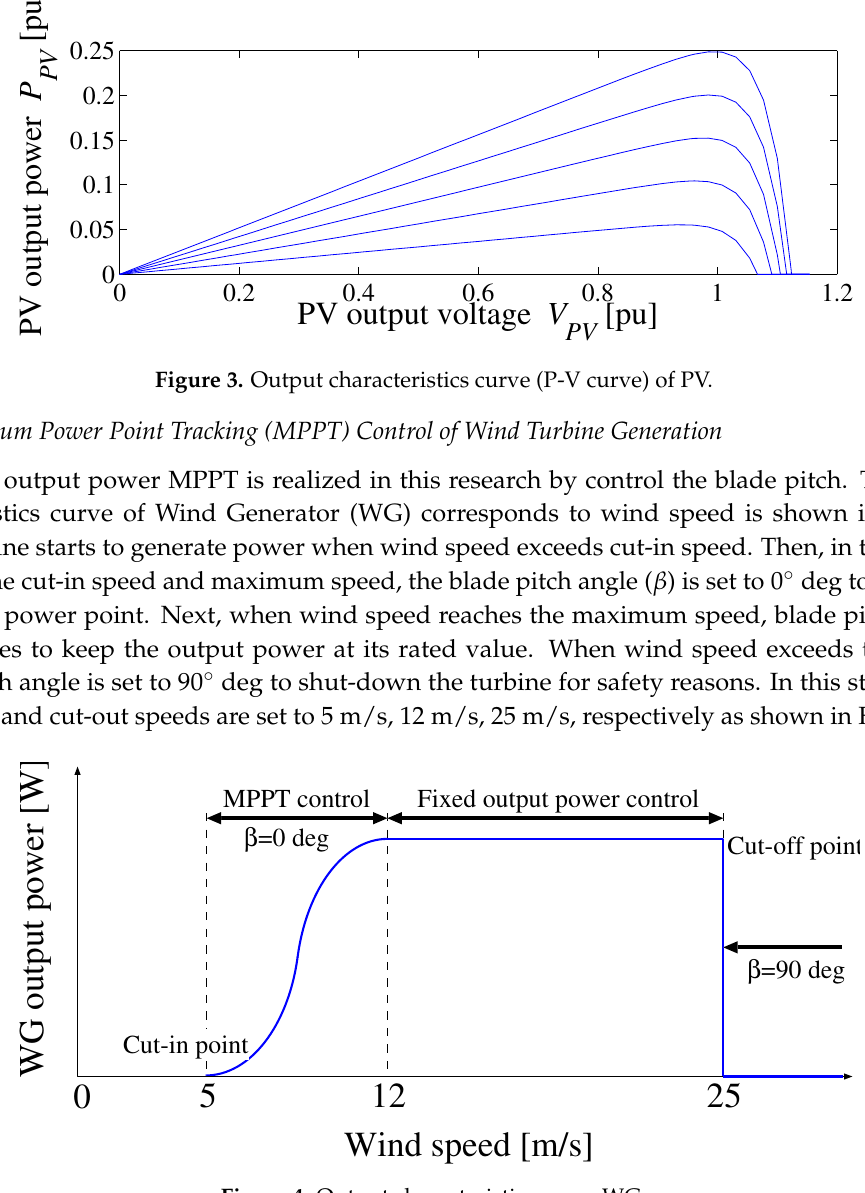
Figure 4. Output characteristics curve